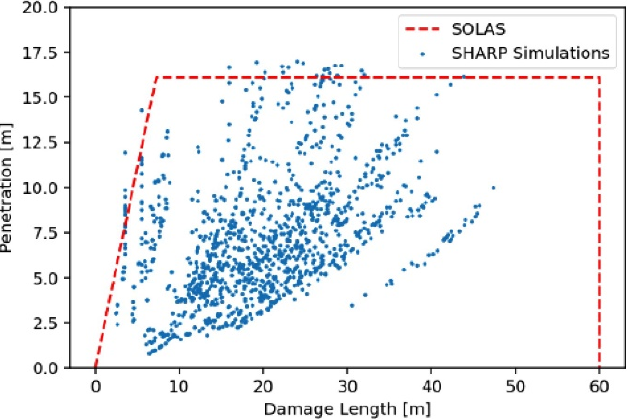
Figure 20. Penetration versus damage length for simulated damages .